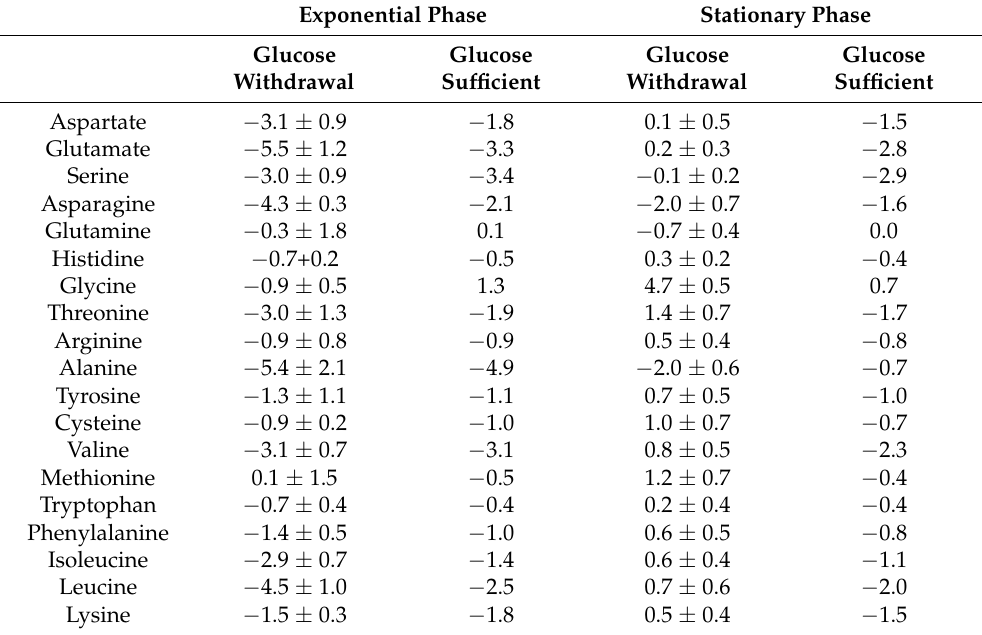
Table 1. Specific consumption rate of amino acids (nmol/10 6